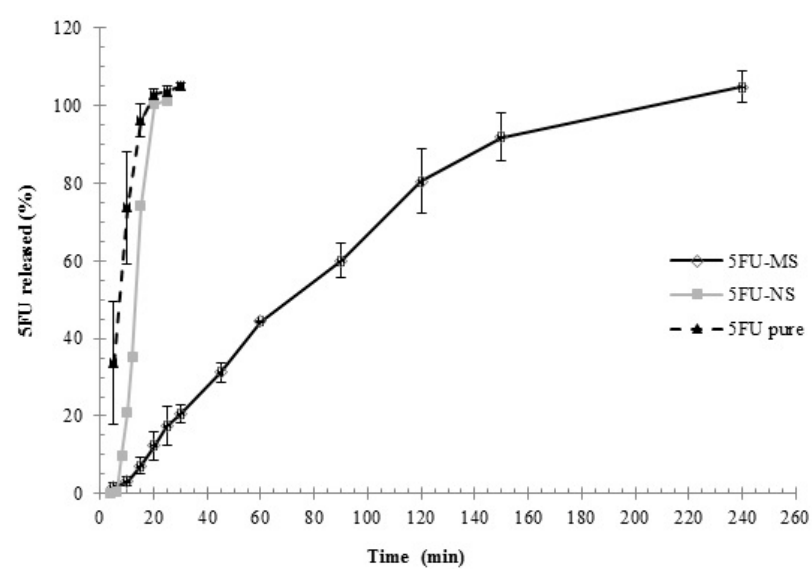
Figure 5. In vitro drug release profile: 5FU-NS and 5FU-MS formulations, and drug 5FU pure (mean ± SD; n = 3).